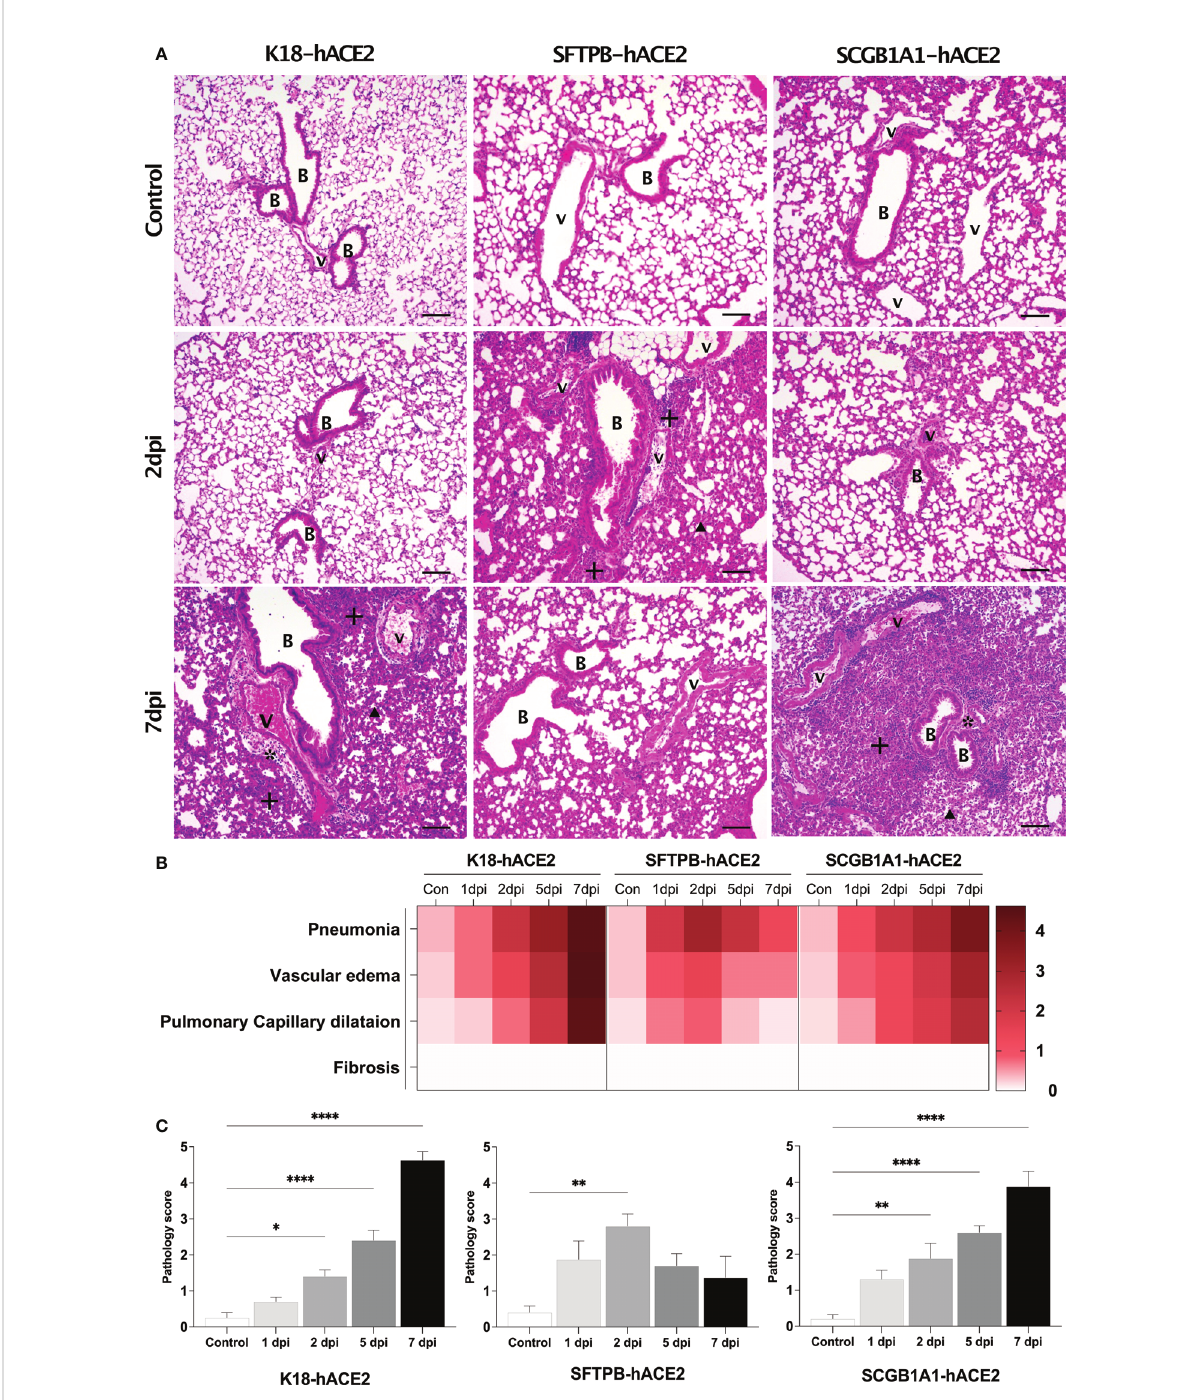
FIGURE 2 Histopathological analysis of SARS-CoV-2-infected lungs in K18-hACE2, SFTPB-hACE2, and SCGB1A1-hACE2 mice. (A) H&E staining of the lungs in each mouse model following mock infection (control, top panels) or intranasal infection with 1 ×10 5 PFU SARS-CoV-2 at 2 dpi (middle panels) and 7 dpi (bottom panels). Infected lungs showed pneumonia (+), vascular oedema (*), and pulmonary capillary dilatation (arrowhead). The scale bars are 100 m m; B, bronchiole; V, vessel. (B) Heatmap showing the histopathological parameters and the average scores for the lung in each mouse model at 1, 2, 5, and 7 dpi, and in the non-infected (control) mice. The severity score ranges from 0 to 5 (0 = none; 1 = weak; 2 = mild; 3 = moderate; 4 = severe; 5; = markedly severe). (C) Lung pathology scoring of SARS-CoV-2-infected mice at 1, 2, 5, and 7 dpi. (* P < 0.05; ** P < 0.01; **** P <